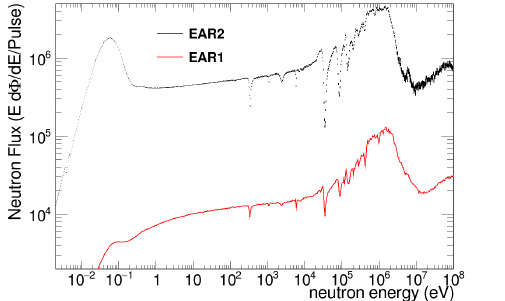
Figure 1. Comparison between the evaluated neutron flux in EAR2 (blue) and in EAR1 (red)